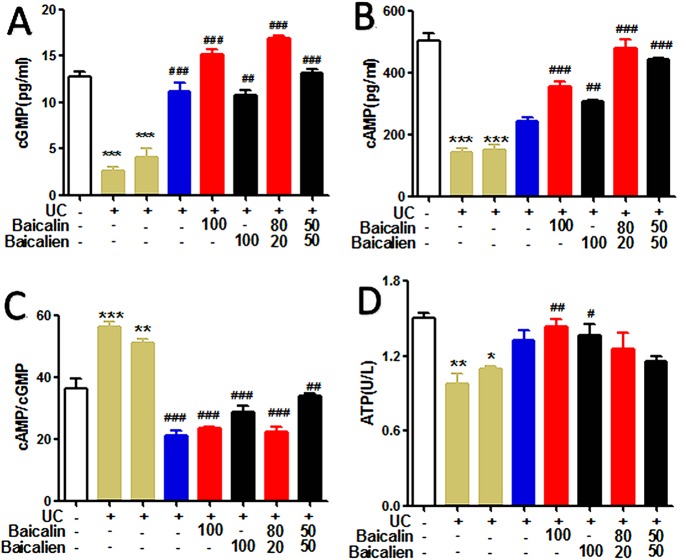
The levels of cAMP, cGMP, cAMP/cGMP and ATP in the rats. (A), cGMP; (B), cAMP; (C), cAMP/cGMP; (D), Na+K–ATP. The data are presented as the mean ± S.D. (n = 7); *P < 0.05, **P < 0.01, ***P < 0.001 compared to the NC group; #P < 0.05, ##P < 0.01, ###P < 0.001 compared to the self-healing group. The left second column is UC group, the left third column is self-healing group, and the left fourth column is SASP group.